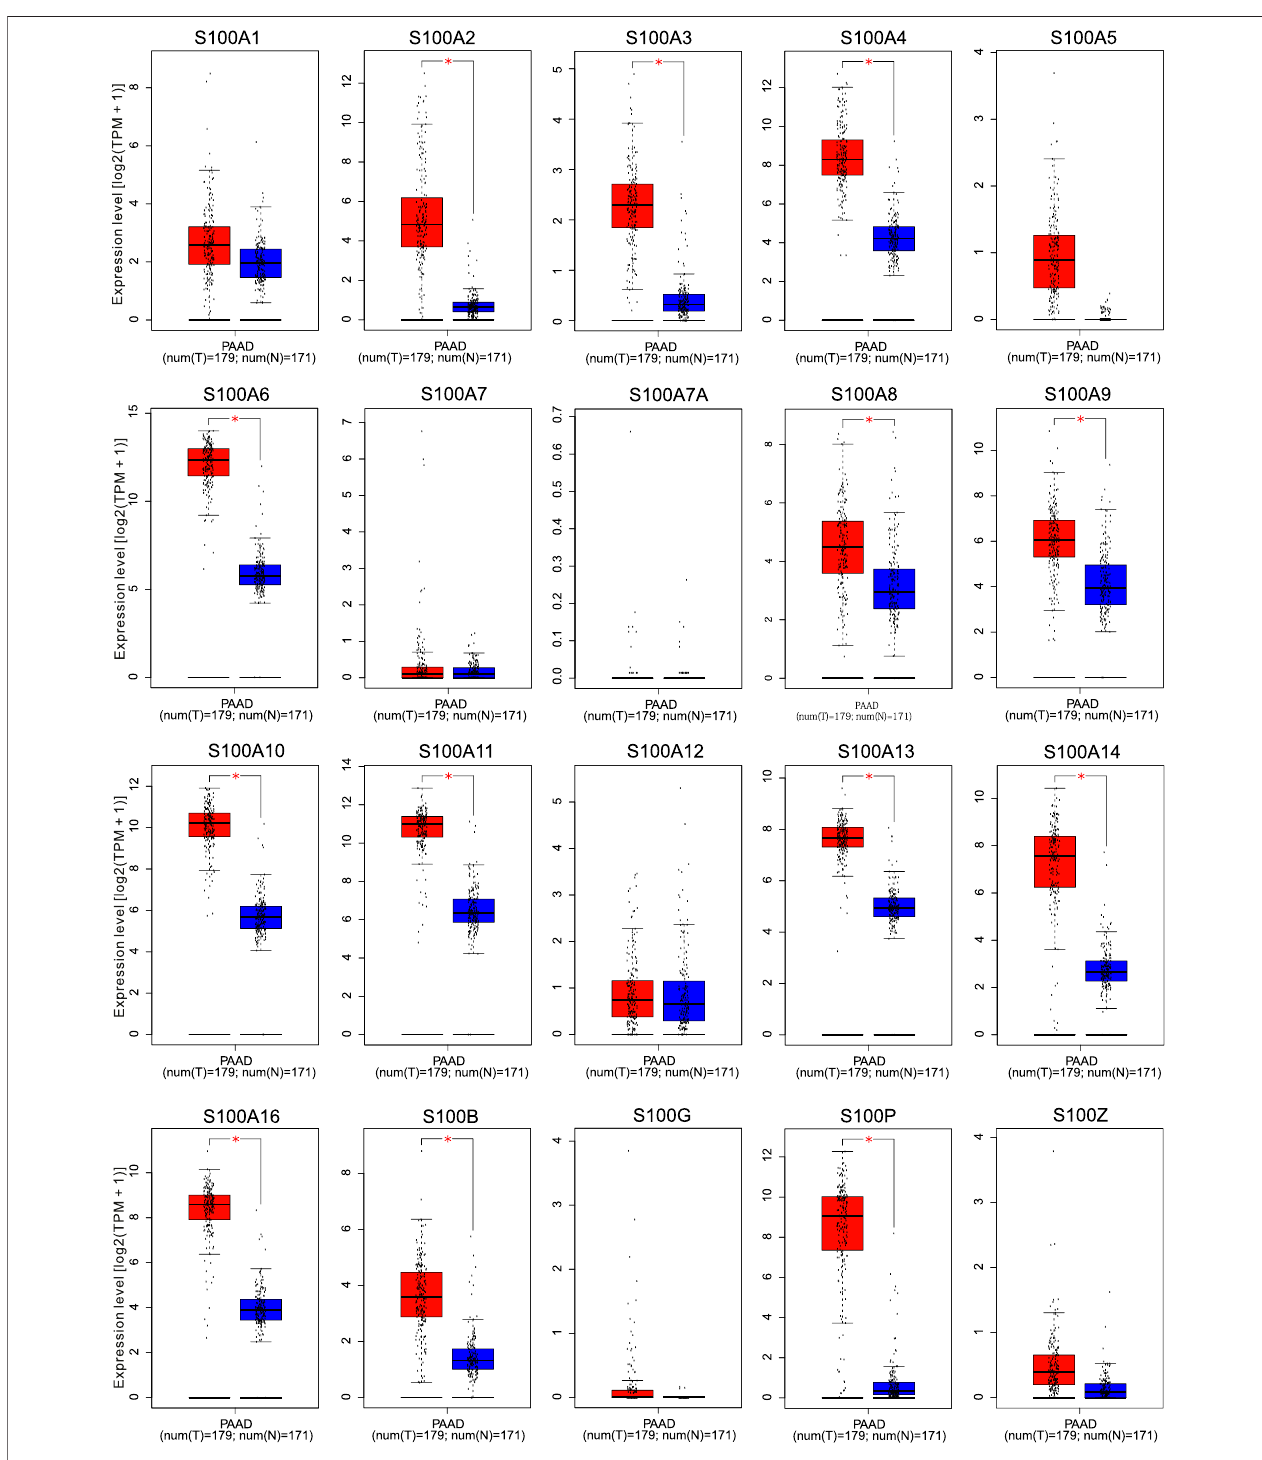
FIGURE2| Thetranscription levels oftheS100family members inPancreatic adenocarcinoma patients usingGEPIA. BoxplotsfromGEPIAgeneexpression data compared the expression of speci fi c S100 family members in PAAD and normal tissues. Select log2 (TPM + 1) transformed expression data for plotting. Blue color represents normal tissue and red color represents tumor tissue. The levels of S100A2/A3/A4/A6/A8/A9/A10/A11/A13/A14/A16/B/P in PAAD tissues were higher than that in normal paired samples as determined by Student ’ s t-test. p < 0.05 was considered to be statistically signi fi cant. Abbreviation: num, sample number; T, tumor; N, normal; TPM, Transcripts per million. * Demonstrate that the results were statistically signi fi cant.